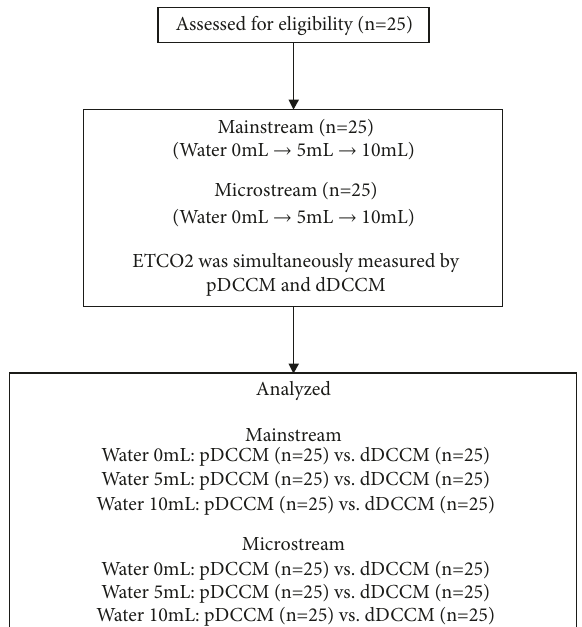
Figure 2: Flow chart of experimental groups . Abbreviations: dDCCM, distal capnometer of direct connect catheter mount; ETCO 2 , End-tidal carbon dioxide; pDCCM, proximal capnometer of direct connect catheter